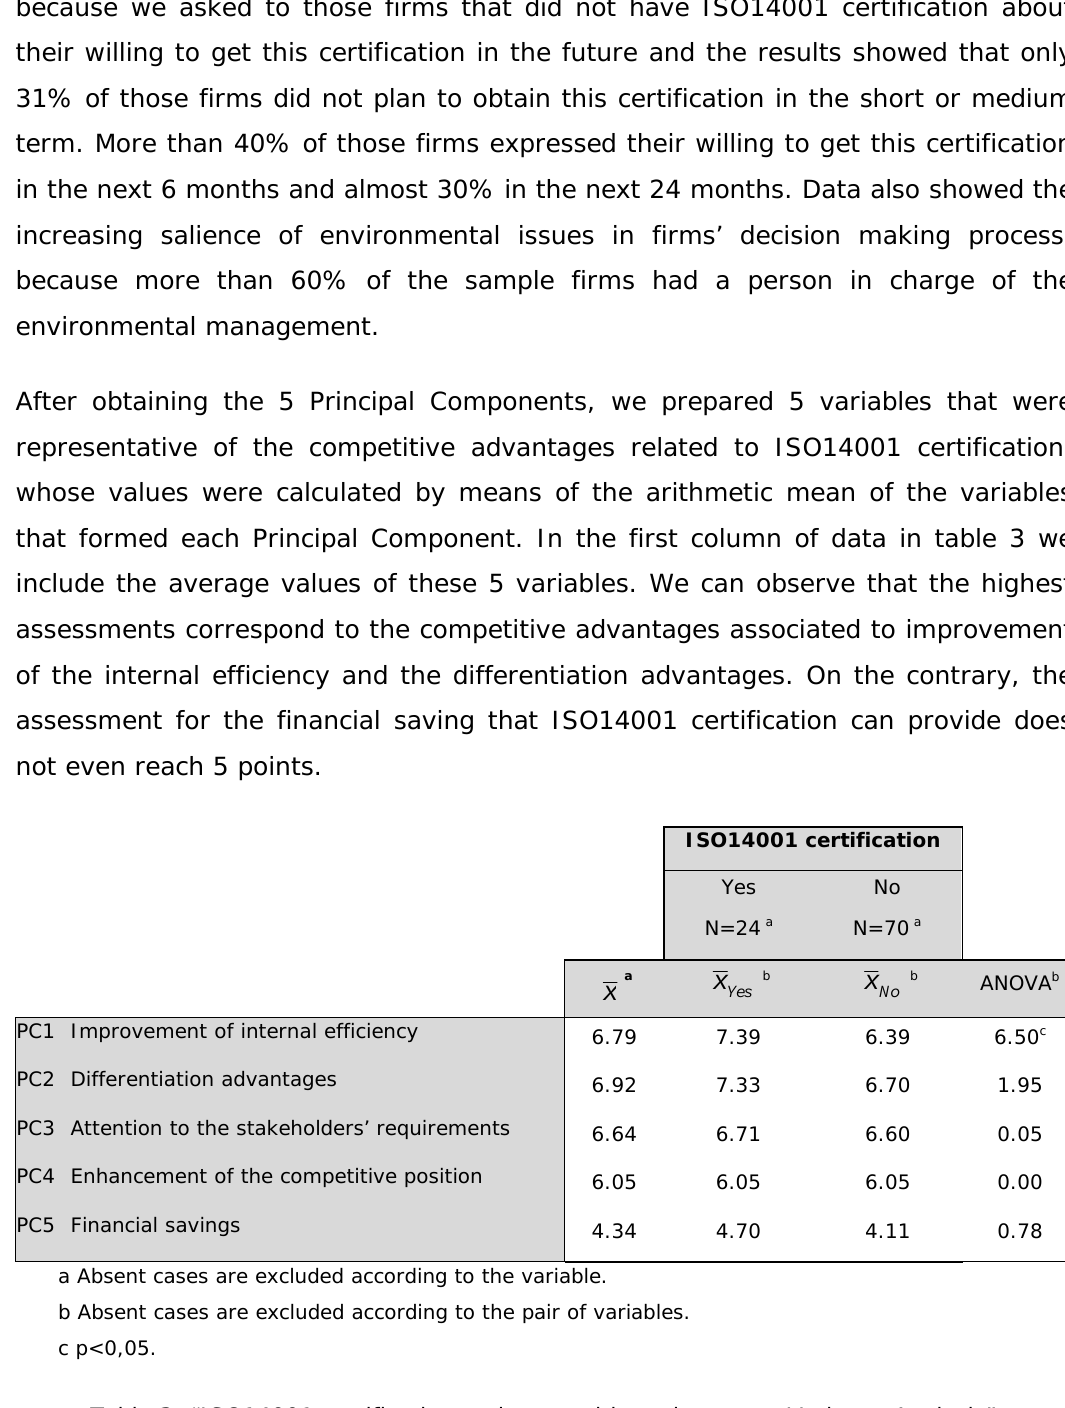
Table 3. “ISO14001 certification and competitive advantage: Variance